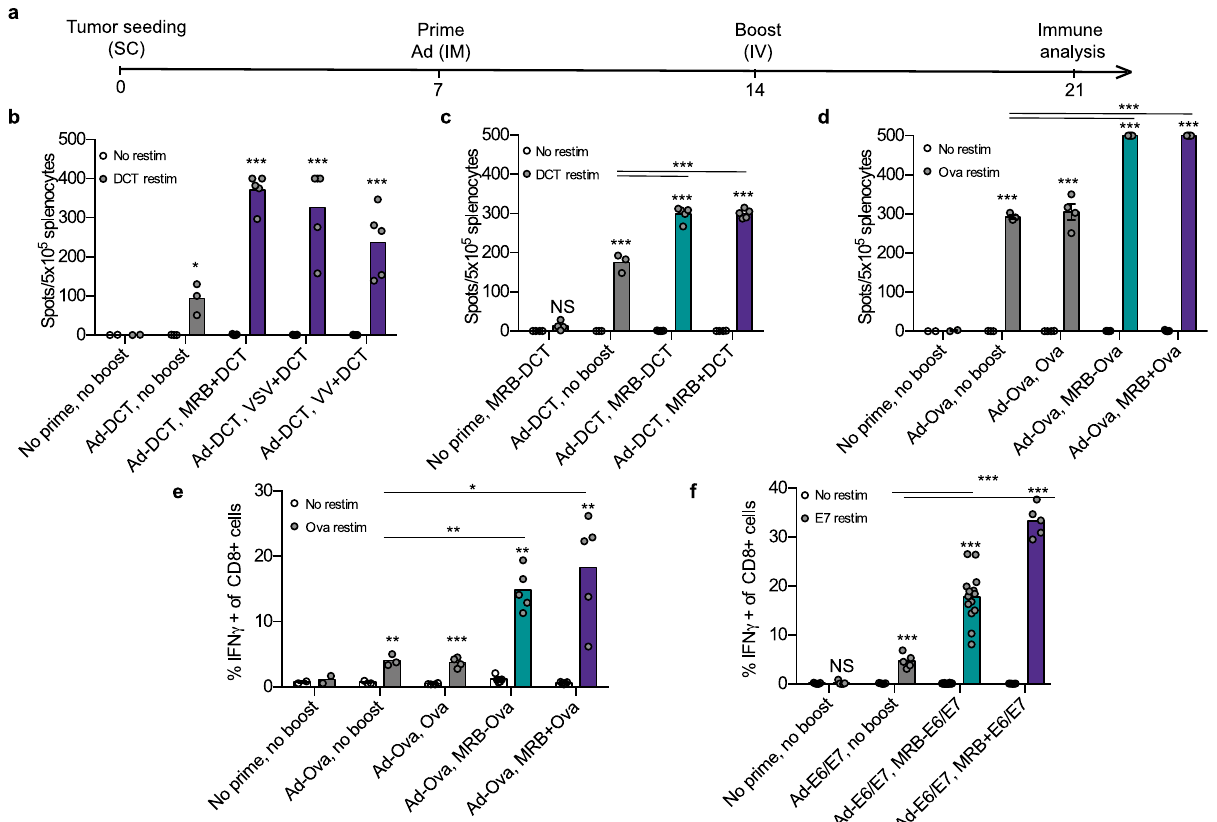
Fig. 2 OVs are effective adjuvants for immune boosting. a Treatment schedule used in this study. b IFN γ ELISPOT analysis of splenocytes from mice primed with Ad-DCT and boosted with either VV, VSV or MRB co-administered with DCT peptide (from left to right; n = 2, 3, 5, 5 and 5); c primed with Ad-DCT and boosted with MRB-DCT or MRB co-administered with DCT peptide (MRB + DCT) (from left to right; n = 4, 4, 5 and 5); d primed with Ad- Ova and boosted with MRB-Ova, MRB co-administered with Ova peptide (MRB + Ova) or Ova peptide only (from left to right; n = 2, 3, 4, 5 and 5). e Flow cytometry analysis of splenocytes from the same experiment as in ( d ) (from left to right; n = 2, 3, 4, 5 and 5) or ( f ) from mice primed with Ad-E6/E7 and boosted with MRB-E6/E7 or MRB co-administered with E6/E7 peptides (from left to right; n = 5, 5, 14 and 5). Unless indicated otherwise, the statistical analyses refer to the comparison between the corresponding ex-vivo “ No restim ” and “ restim ” conditions. NS: p > 0.05, *: p < 0.05, **: p < 0.01, ***: p < 0.001 (unpaired two-tailed t -test). Source data are provided as a Source Data fi le. Exact p values can be found in the Source